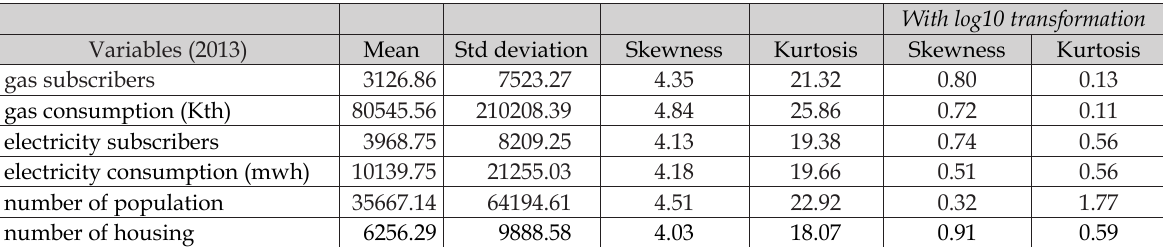
fig. 3. Consumption of (a) electricity and (b) gas by residential buildings in 2013. Table 1. Mean values, standard deviation and test of normality of the